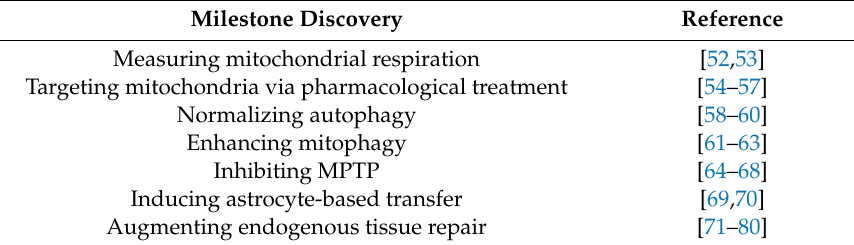
Table 1. Recent Discoveries in Mitochondrial Repair for